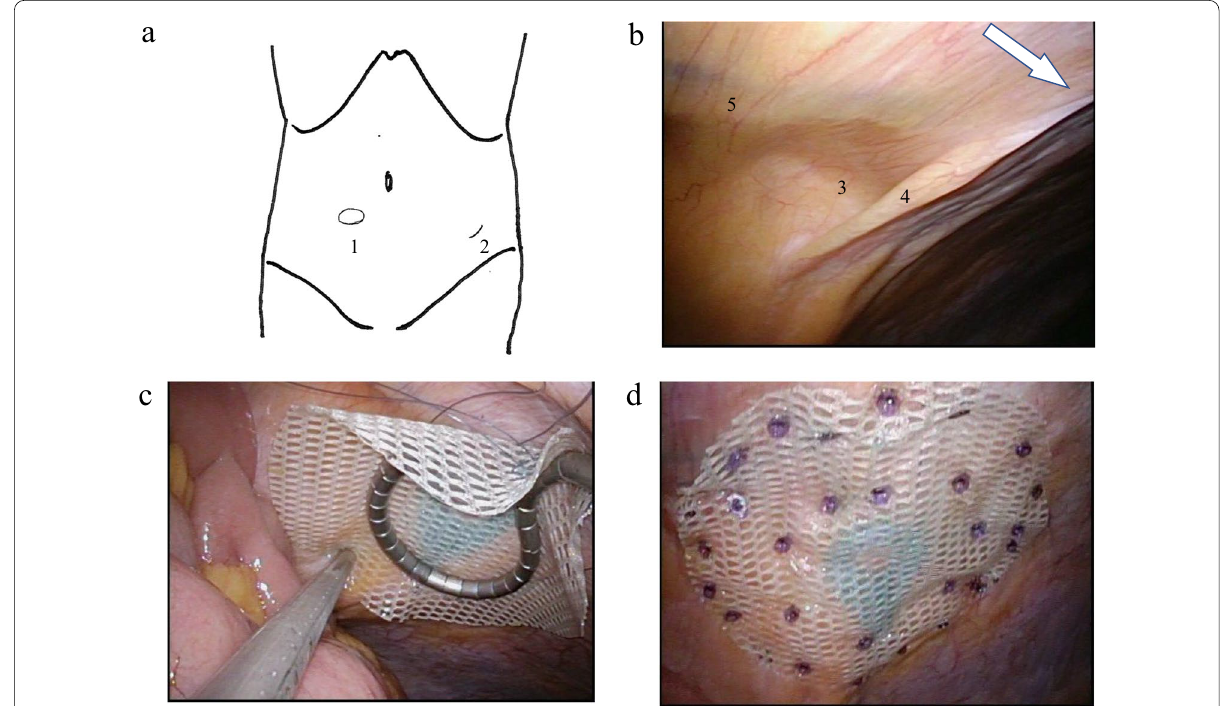
Fig. 3 Operative findings: a location of the hernia ( 1 ) and skin incision ( 2 ). b The arrow indicates the cranial side. The hernia ( 3 ) is above the arcuate line ( 4 ) and lies along the inferior epigastric vessels ( 5 ). c The first tack to fix the mesh involved using the Diamond-Flex ® circular retractor to stabilize the mesh position. d The mesh is secured using the double-crown